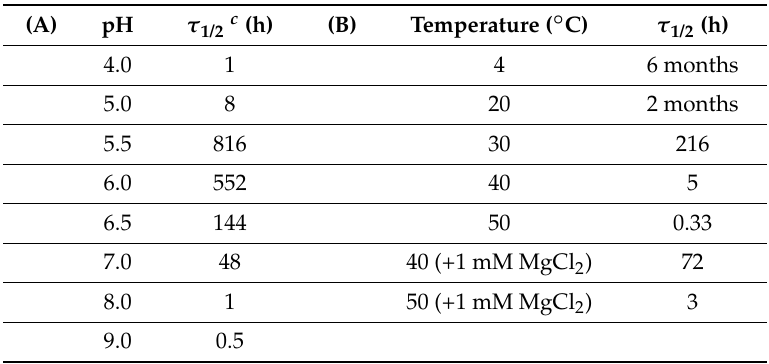
Table 2. Effect of pH ( A ) a and temperature ( B ) b on catalytic stability of recombinant β